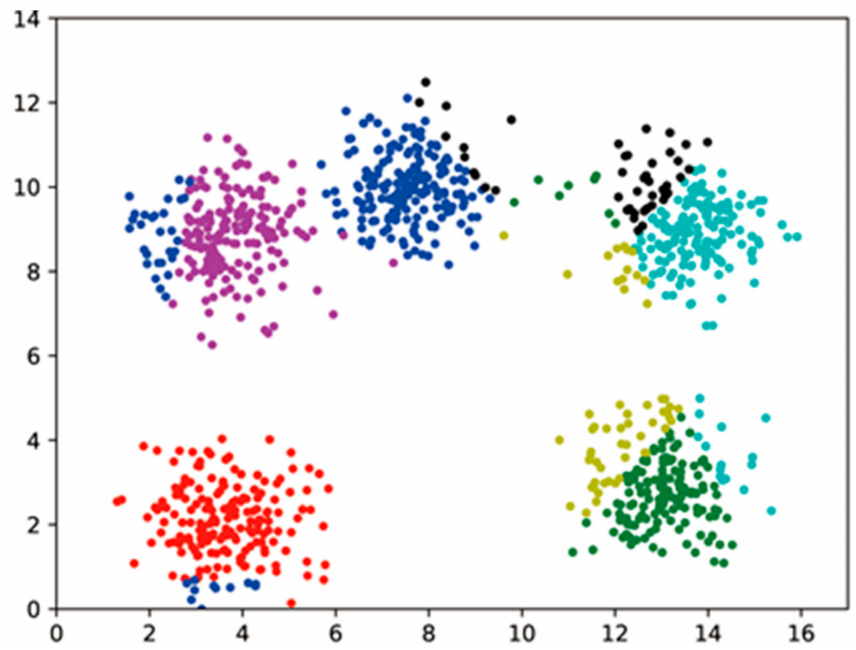
Figure 9. Dataset A Ciphertext clustering results with 3 decimal places.